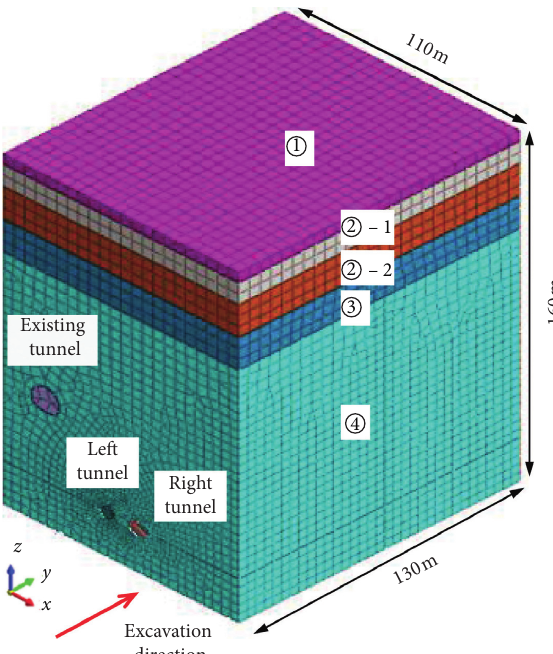
Figure 3: Three-dimensional model of underpass